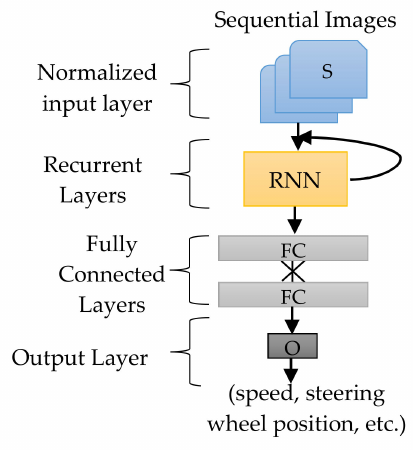
Figure 6. Sequential data e2e architecture